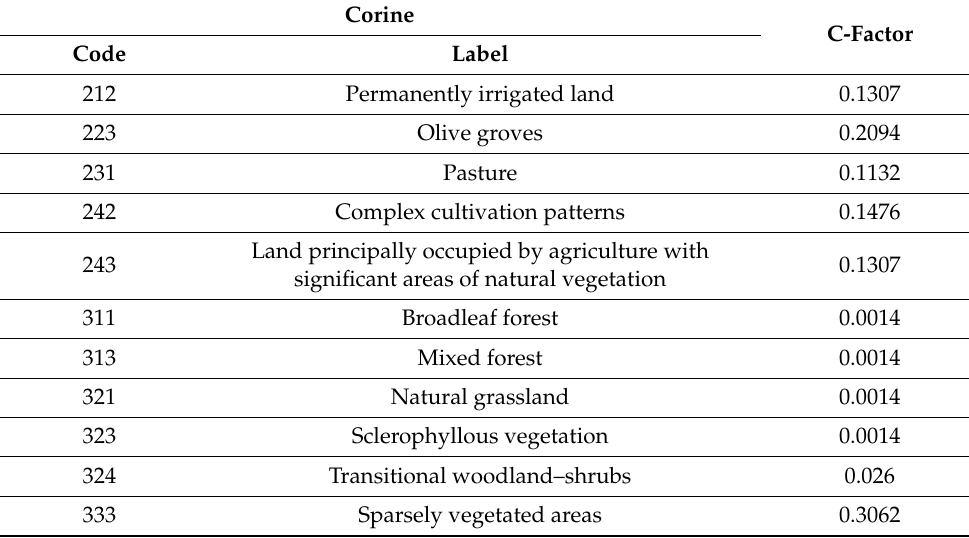
Table 4. Assigned C-factor values from literature